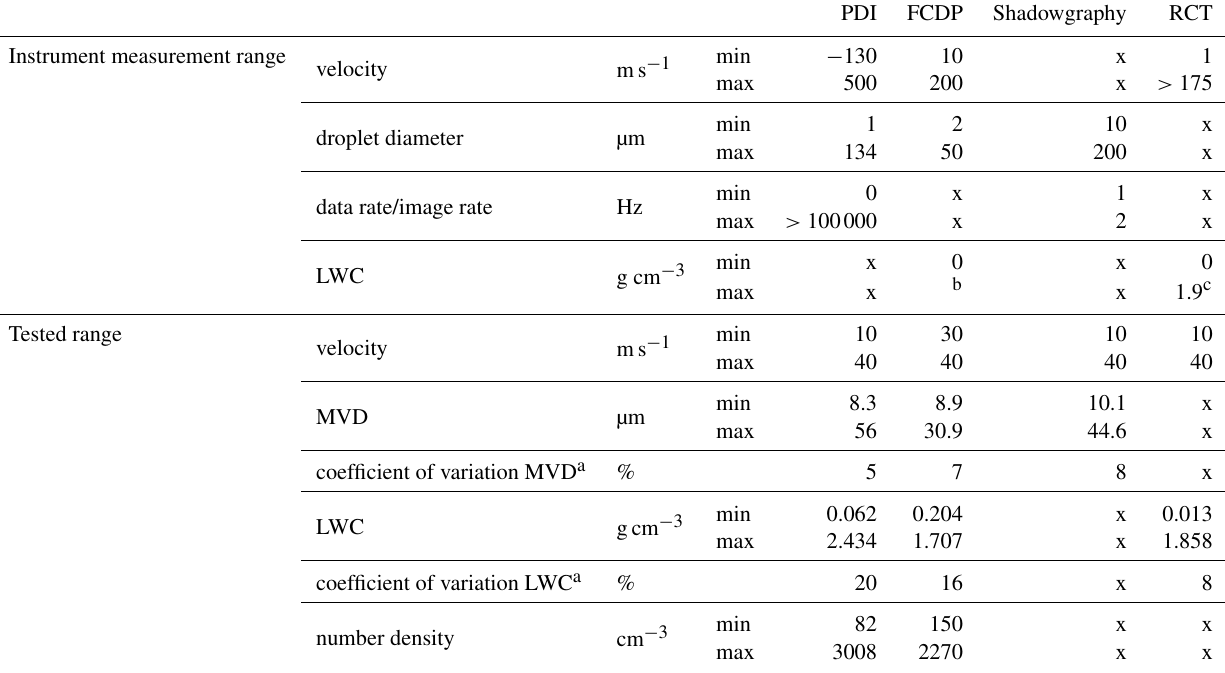
Table 4. Summarized instrument and test conditions.